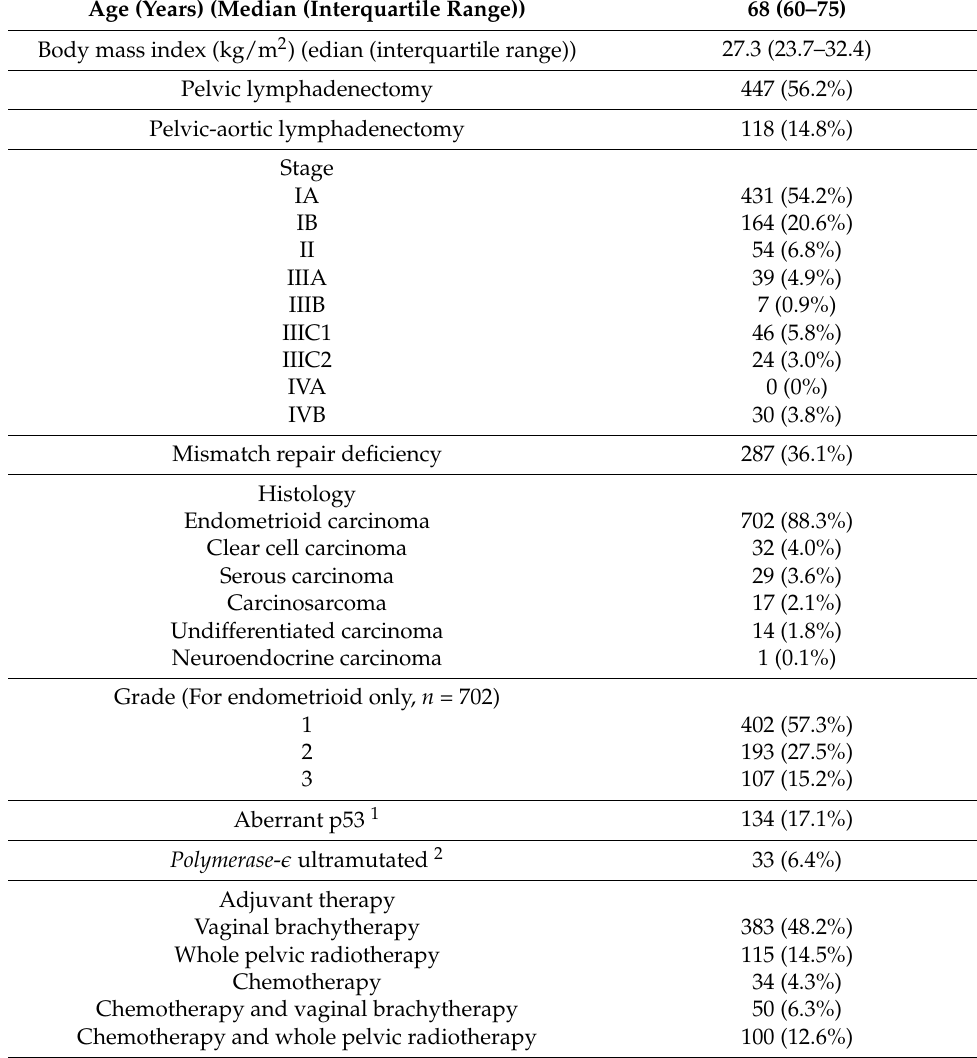
Table 1. Characteristics of the complete cohort ( n =